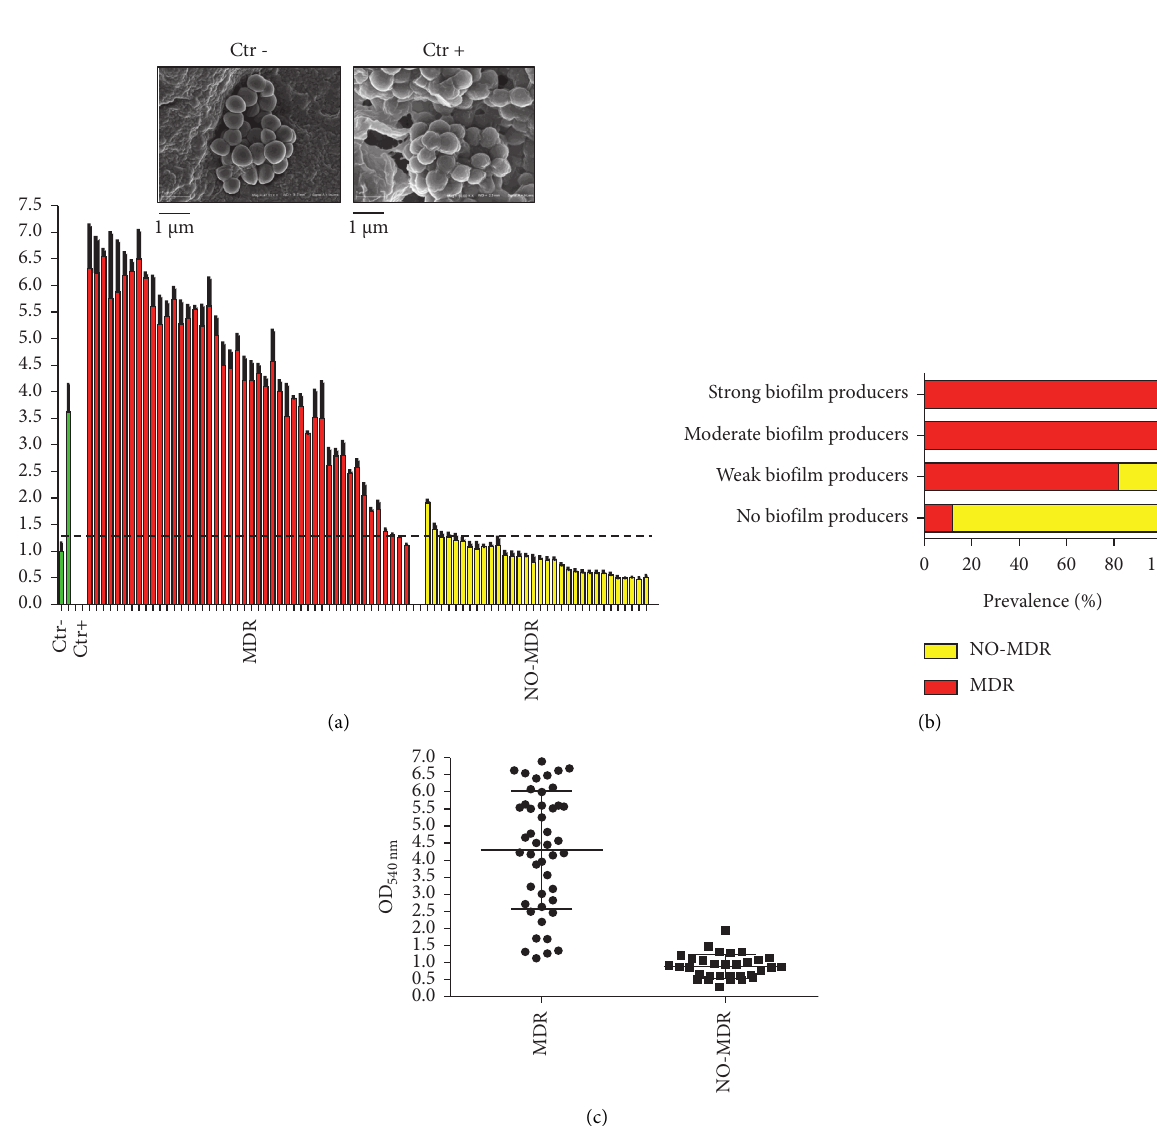
Figure 5: Biofilm formation analysis of MD isolates. (a) Biofilm production level of MDR, red bars, and NO-MDR, yellow bars. The green bars indicate negative and positive controls, also represented by SEM. Dashed line represents the cutoff value. (b) Prevalence of MDR and NO-MDR strains among the different biofilm productions. (c) Distribution of biofilm formation with indicated resistance phenotypes.